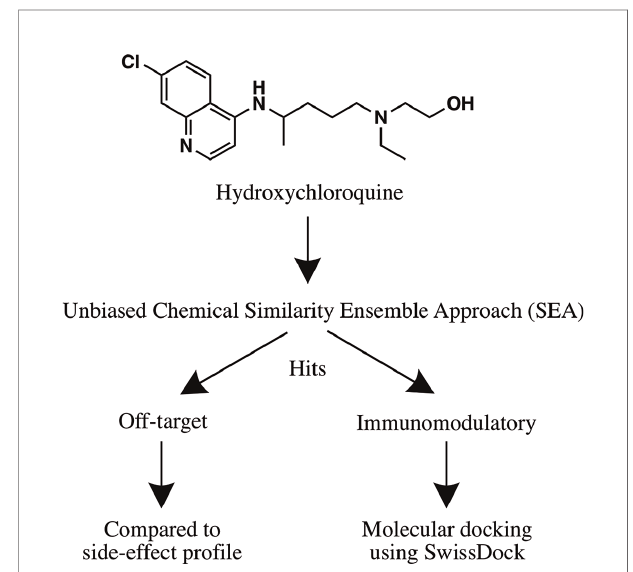
FIGURE 1 | Flowchart summarizing the in silico approach employed to identify the immunomodulatory targets of